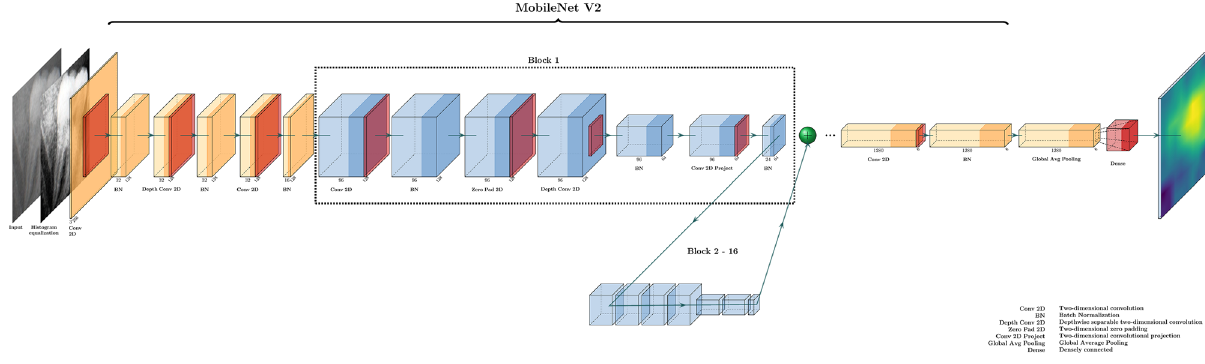
Figure 5. MobileNet